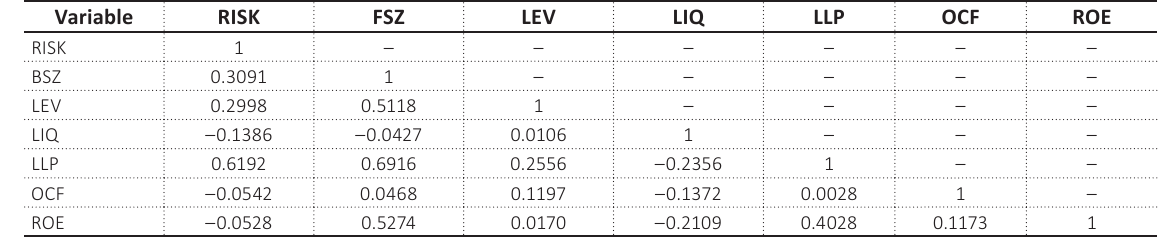
Source: Analytical data from EViews